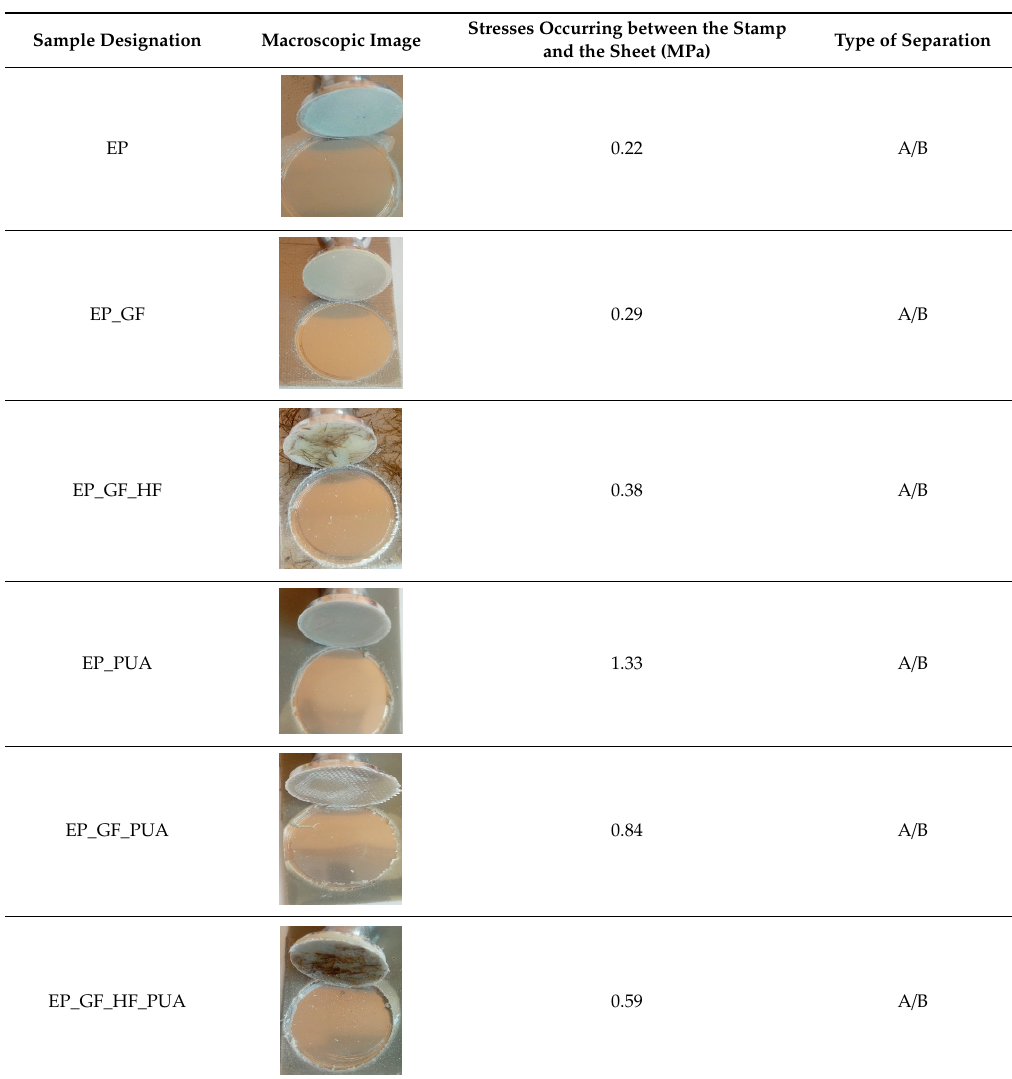
Table 7. Results of the adhesion pull-o ff